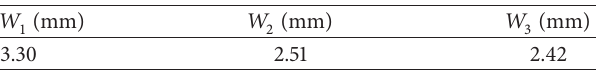
Table 2: Single-track clad width values obtained at different trans- lation